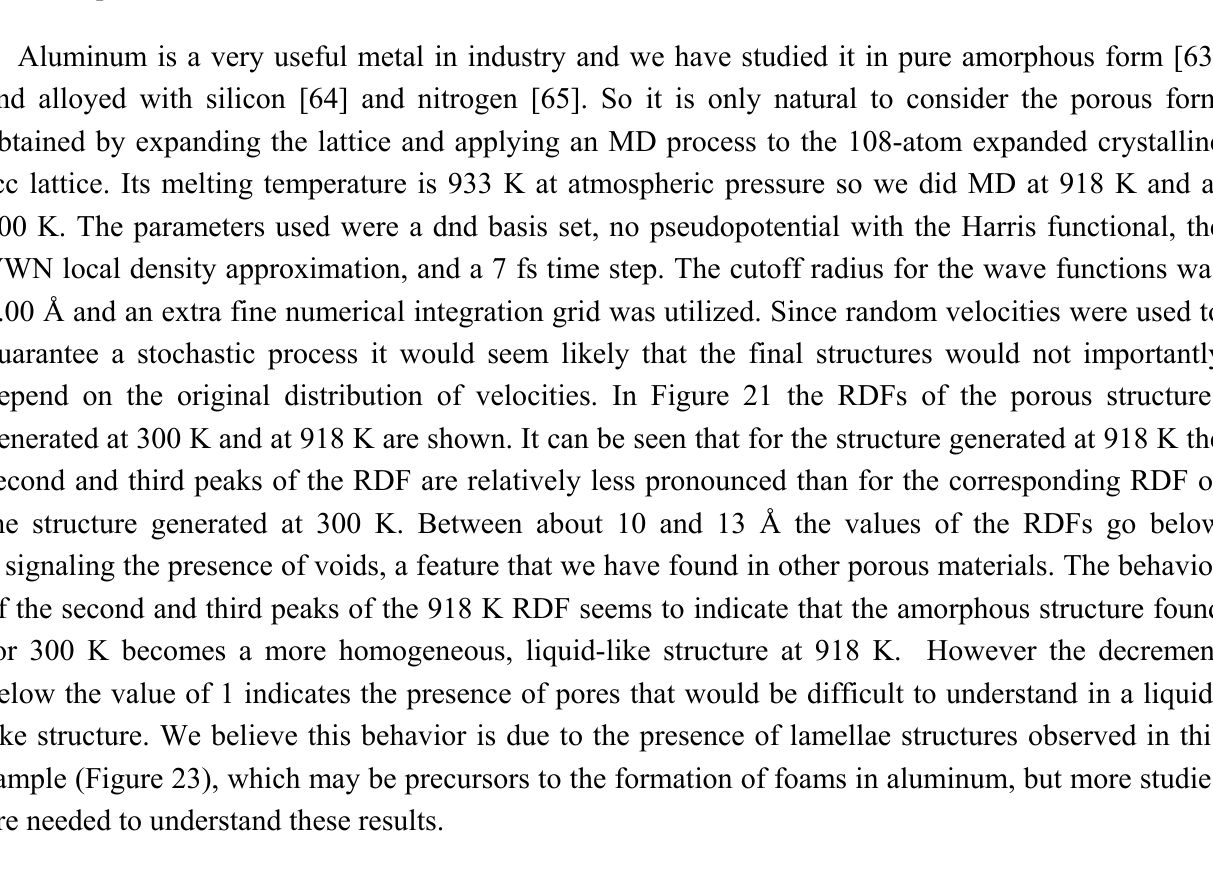
Figure 21. Radial (pair) distribution functions, RDFs, for 50% porosity supercells with 108 aluminum atoms after 500 steps of MD processes at 300 K and at 918 K. See